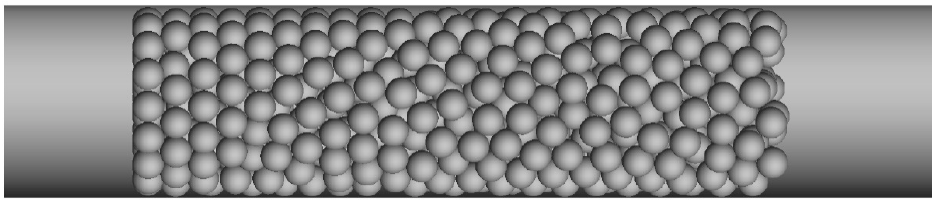
Figure 1. Geometrical model of the packed bed reactor.